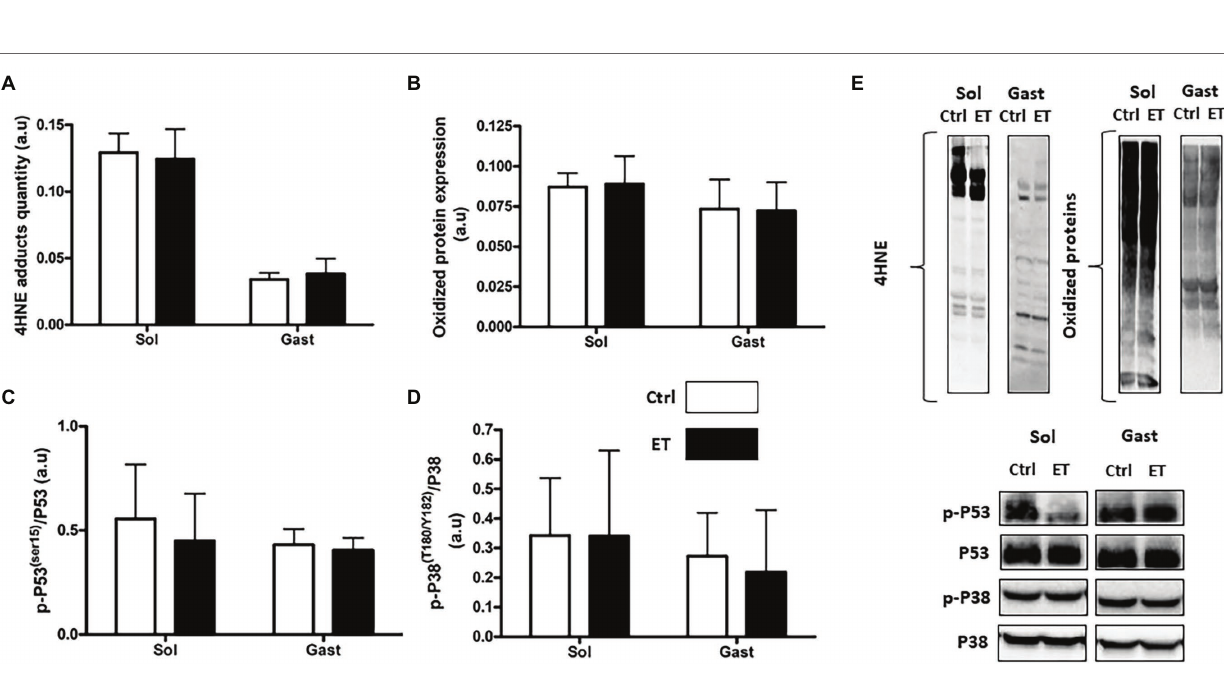
FIGURE 9 | Ergothioneine effect on oxidative stress markers 2 h after exercise. Oxidative stress markers in soleus and gastrocnemius samples. (A) 4HNE adduct quantification. (B) Oxidized protein expression. (C) Phosphorylated p53 (Ser15)/total p53 ratio. (D) Phosphorylated p38(Thr180/Tyr182)/p38 ratio. (E) Representative Western Blots; * p < 0.05 vs.